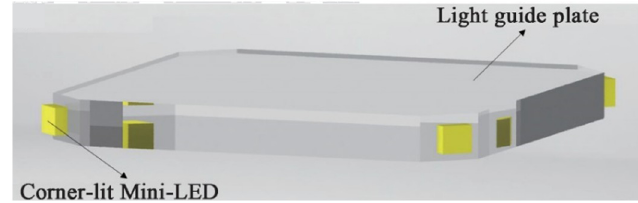
Figure 8. Corner-lit backlight unit [21].